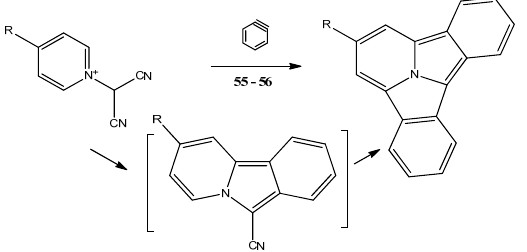
Table 13. Substituents and yields of benzocyclazines from pyridinium ylide (Scheme 29). N R A, Yield, % B, Yield, % C, Yield, % Ref. 55a